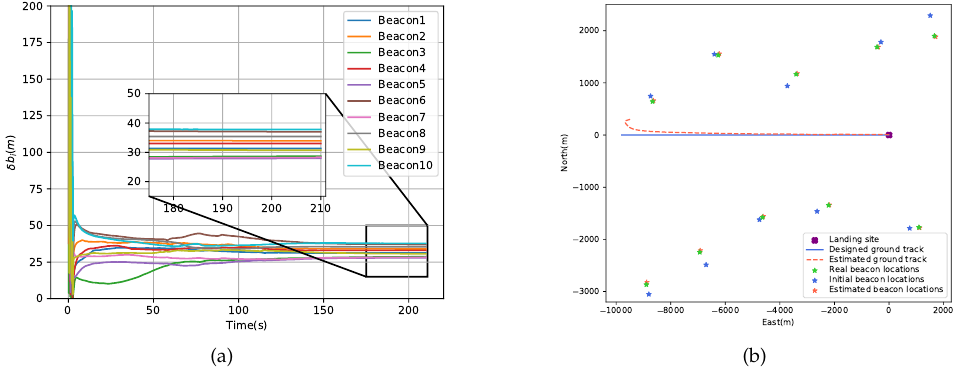
Figure 9. Performance of the proposed scheme in the mapping of the beacon configuration. ( a ) Residuals of all estimated beacon locations. ( b ) The beacon map and ground track before and after the